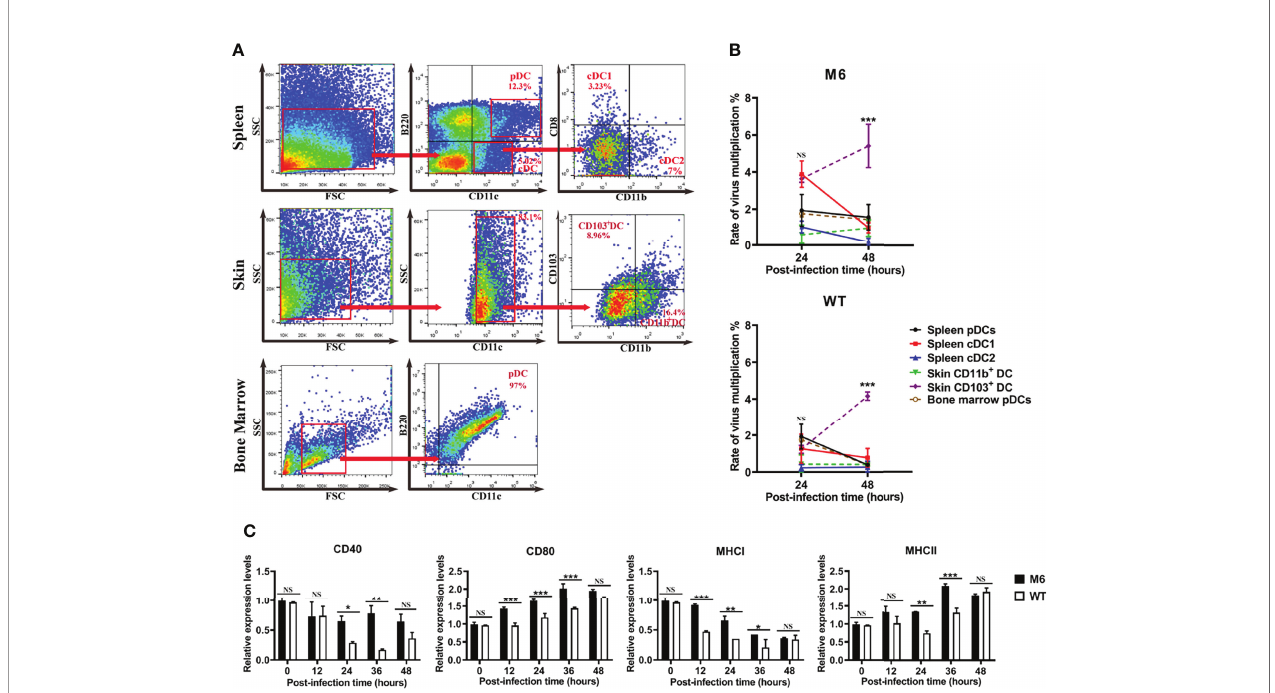
FIGURE 4 | M6- and WT-infected dendritic cells. (A) Flow cytometric sorting of dendritic cells from different tissues. (B) Rate of virus multiplication in dendritic cells with different surface markers after M6 and WT infection ((the viral load (24 or 48 h)-the viral load (0 h))/the viral load (0 h)). The black circle represents the data in spleen pDCs infected with the virus, the red square represents those in infected-spleen-cDC1, the blue triangle represents those in infected-spleen-cDC2, the green triangle represents those in infected-skin-CD103 + DC, the purple circle represents those in infected-skin-CD11b + DC, and the brown circle represents those in infected-bone-marrow-pDCs. (C) mRNA expressions of key surface markers on dendritic cells infected with M6 (circle) and WT (square). The relative expression levels of key surface markers in dendritic cells were normalized to their levels in the blank control group (without viral infection) using the comparative Ct ( DD Ct) method. The data are shown as the mean ± SEM based on data from three independent experiments. * P < 0.05, ** P < 0.01, *** P < 0.001, **** P < 0.0001. NS, no signi fi